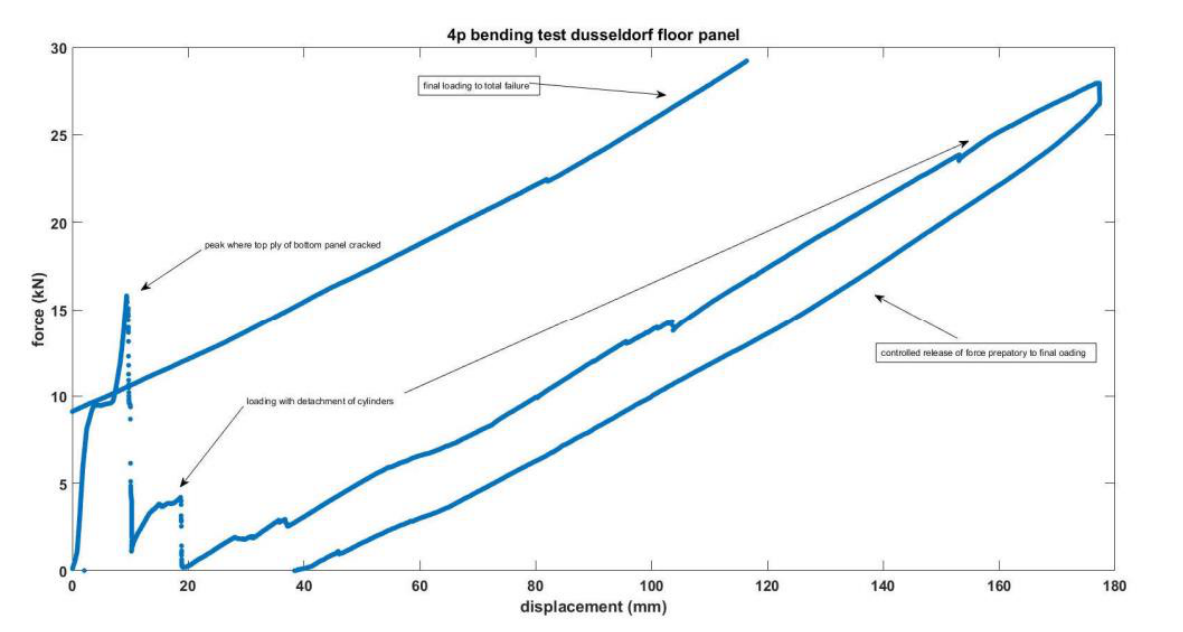
Fig. 21 Force displacement diagram of